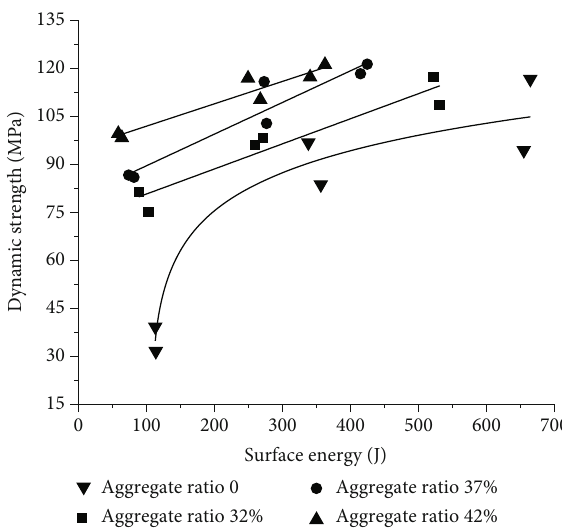
Figure 13: Crack surface energy and dynamic compressive